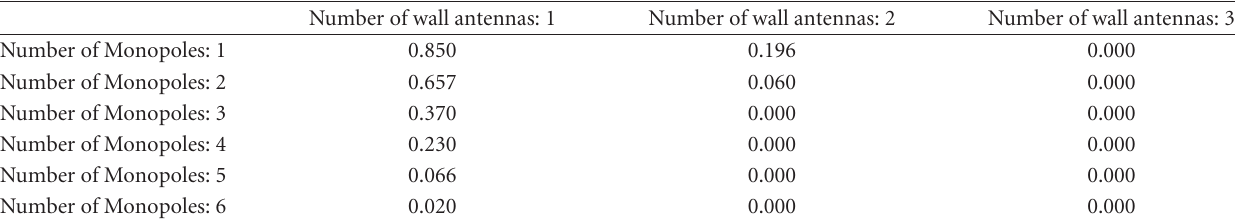
Table 1: P value of Henze-Zirkeler’s